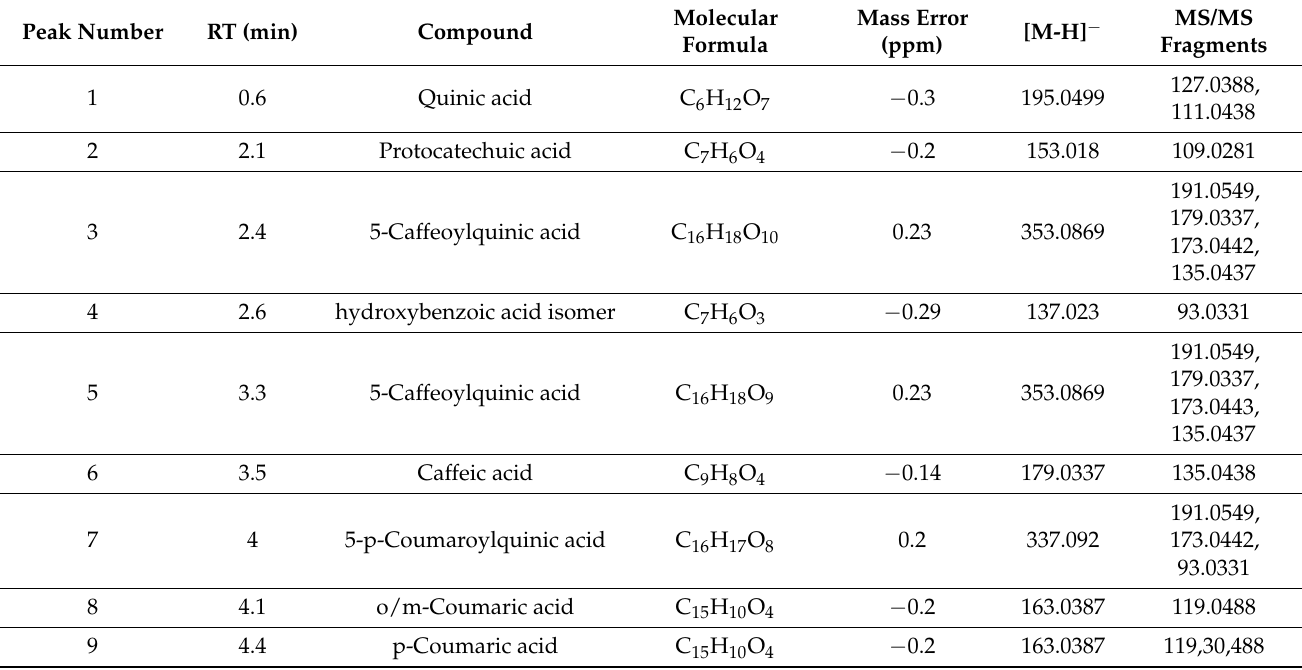
Table 3. Polyphenols identified in A. borbonica plant